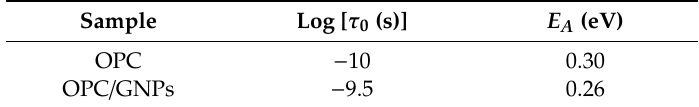
Table 4. Activation Energy ( E A ) and pre-Exponential Factor (log [ τ 0 (s)]) values obtained from the Arrhenius equation applied to data in Figure 8.